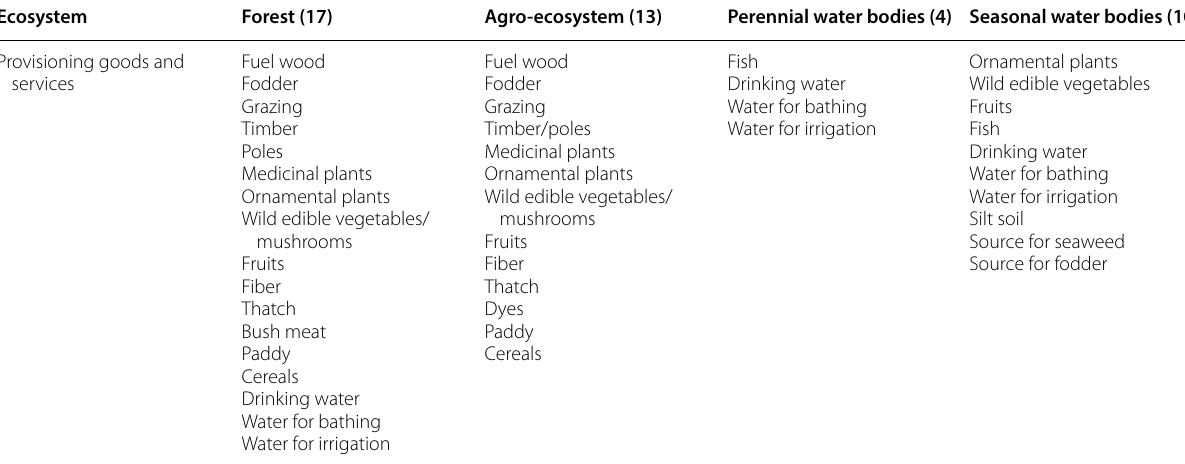
Table 5 Number of provisioning ES utilized by local communities for their livelihoods Ecosystem Forest (17) Provisioning goods and